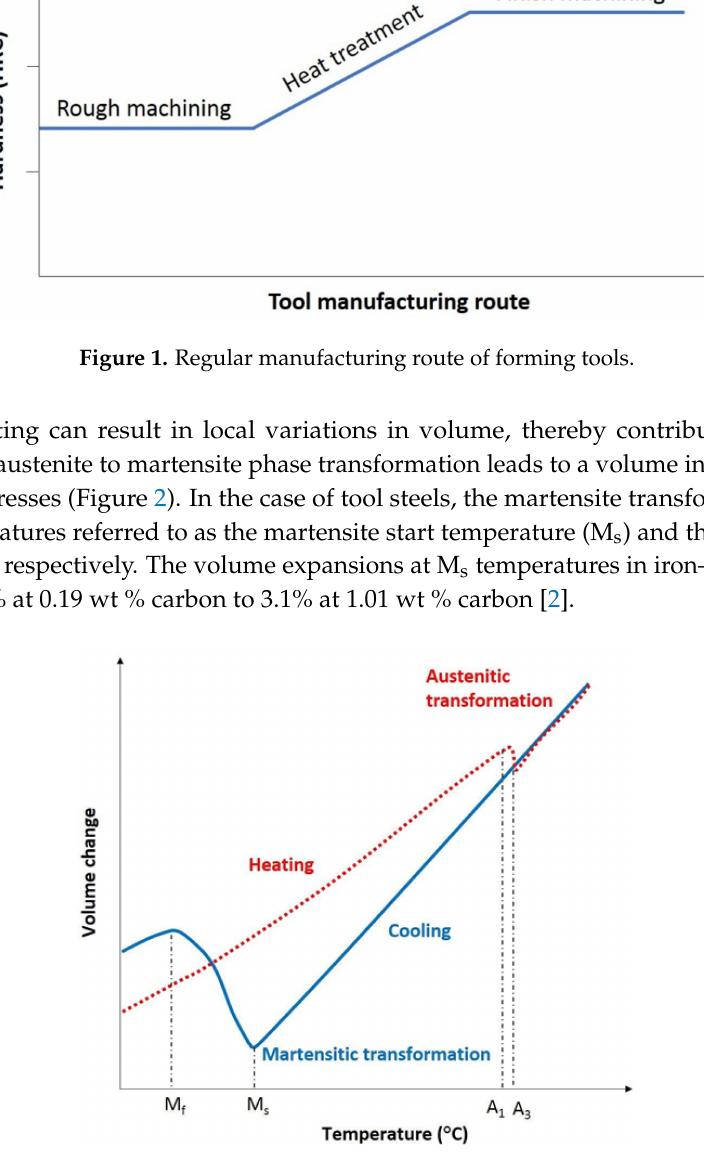
Figure 2. Schematic of volume change induced by the phase transformation (adapted from